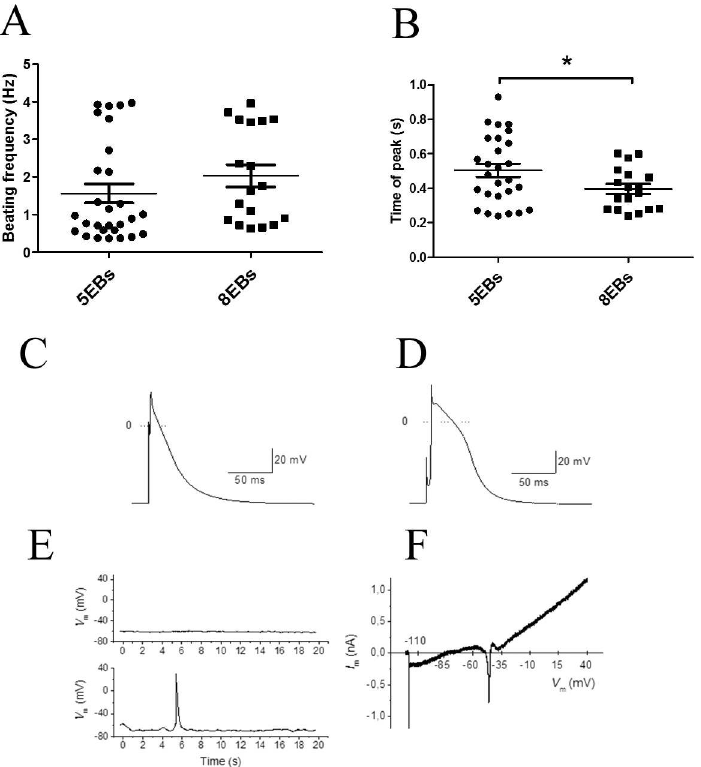
Fig 5. Electrophysiological characteristics of differentiated cardiomyocytes. Beating frequency (A) and duration of peak width (B) analyses by Ca 2+ flux in formed 5EB and 8EB cardiomyocytes on day 20 of differentiation. Data are expressed as mean ± SEM (n = a minimum of 4). Differences between samples were analyzed by paired T-test and considered statistically significant for p (cid:20) 0.05; they are marked with asterisks. Representative action potential recordings from cells stimulated with suprathreshold current pulses (0.5 ms, 4–10 nA) at 1 Hz; a cells with atrial (C) and ventricular (D) action potential morphology. In the majority of cells, we did not observe any spontaneouselectrical activity during 20-s recordings (E; upper panel); occasionally, a single spontaneous AP appeared during this period (E; lower panel); V m − membrane voltage. Whole cell membrane current during a 5-s ramp pulse at voltages between -110 and +40 mV (F); I m − membrane current.